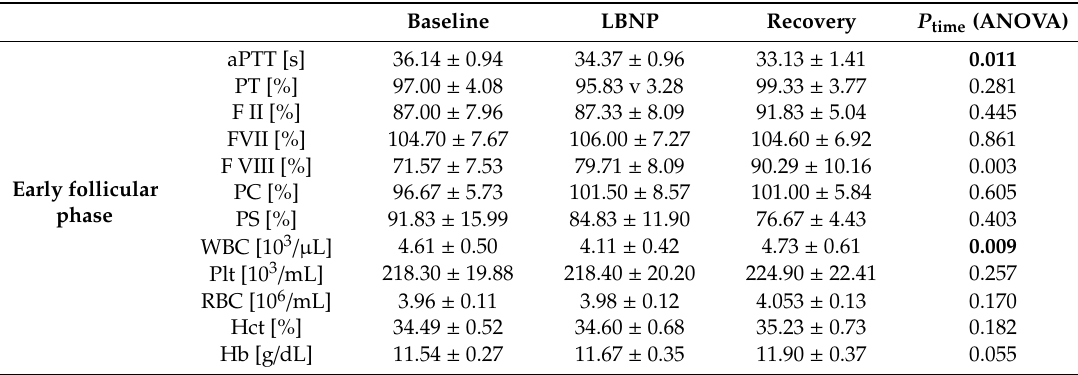
Table 1. An overview of all the coagulation and hematological values at rest, during lower body negative pressure (LBNP) and recovery. Significant changes are highlighted in